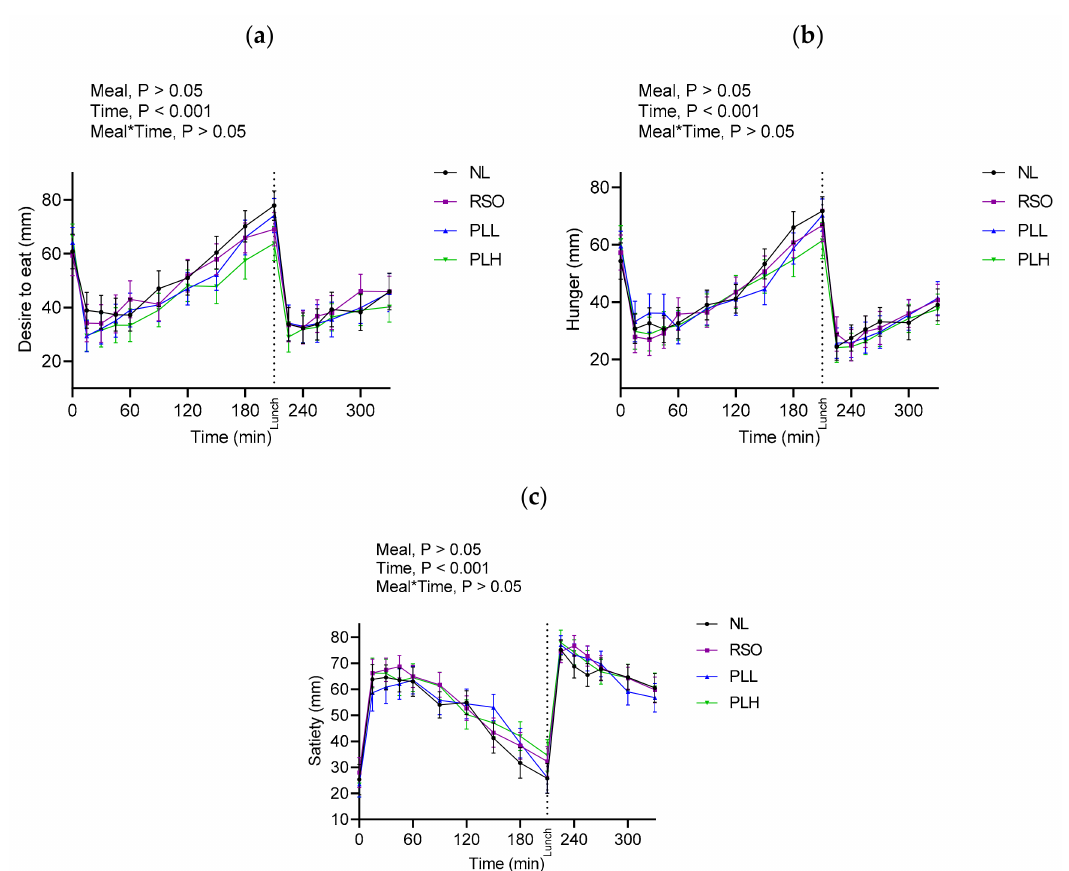
Figure 10. Subjective appetite ratings after test breakfasts and standardized lunch meals. Values are means ± SEM of subjective appetite ratings (VAS) of ( a ) desire to eat, ( b ) hunger, and ( c ) satiety; n = 20 healthy subjects. Repeated measures; mixed model in SAS. NL, oat preparation without added lipids; RSO, oat preparation added with rapeseed oil; PLL, oat preparation with a low concentration of polar lipids; PLH, oat preparation with a high concentration of polar